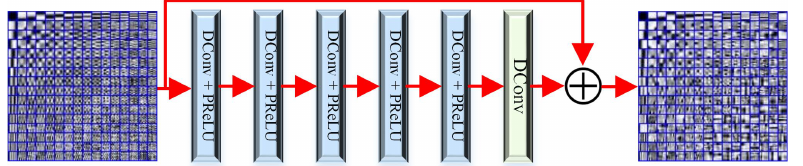
Figure 4. The flowchart of the deep dictionary network Φ ( · ) . “DConv” denotes dilated convolution, while “PReLU” represents the parametric rectified linear unit. “ + (cid:13) ” is a pixelwise operator used to add feature